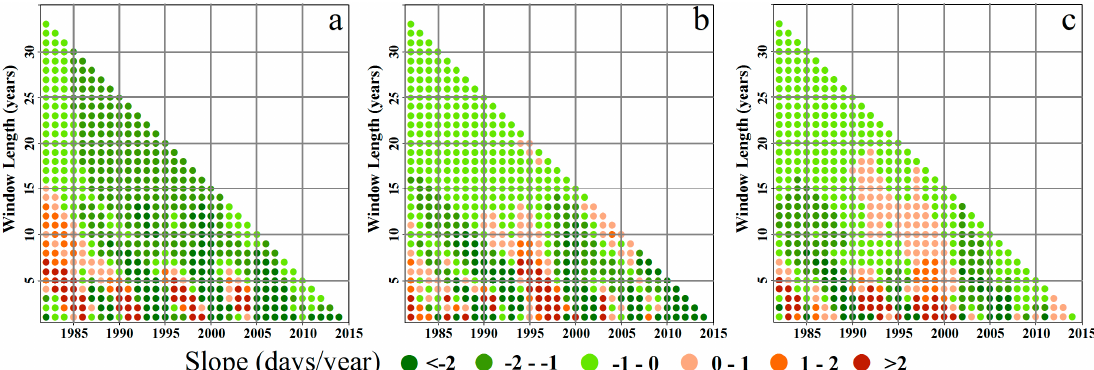
Figure 5. The change trends of SOS for different vegetation types with different window lengths (i.e., study period): ( a ) meadow steppe; ( b ) typical steppe and ( c ) desert steppe. Each dot represents mean trends of each vegetation type over a single window size (1–33 years) for each start year (1982–2014). Only statistically significant trends ( p < 0.05) are included in this analysis. The red (green) color indicates positive (negative) trends.